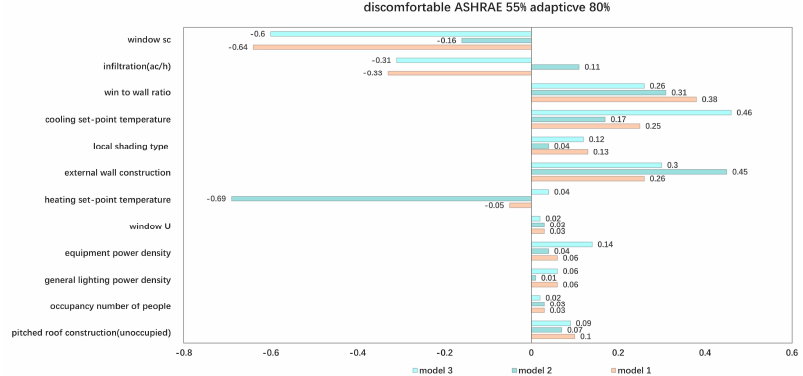
Figure 18. SRC for each parameter for 55% of discomfortable ASHRAE. As shown in the picture 18, Under the ASHRAE 55 discomfort standard, the solar heat gain coefficient in Models 1 and 3 showed more sensitivity to comfort. However, in Model 2, the results were different from the All-Cloth discomfort standard. The heating